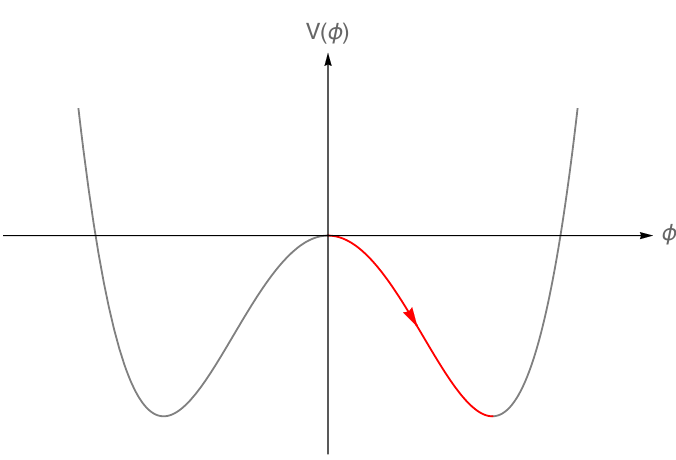
Figure 3 . When the temperature is lowered down, the flow of the near horizon value of the scalar field is shown in the red line with